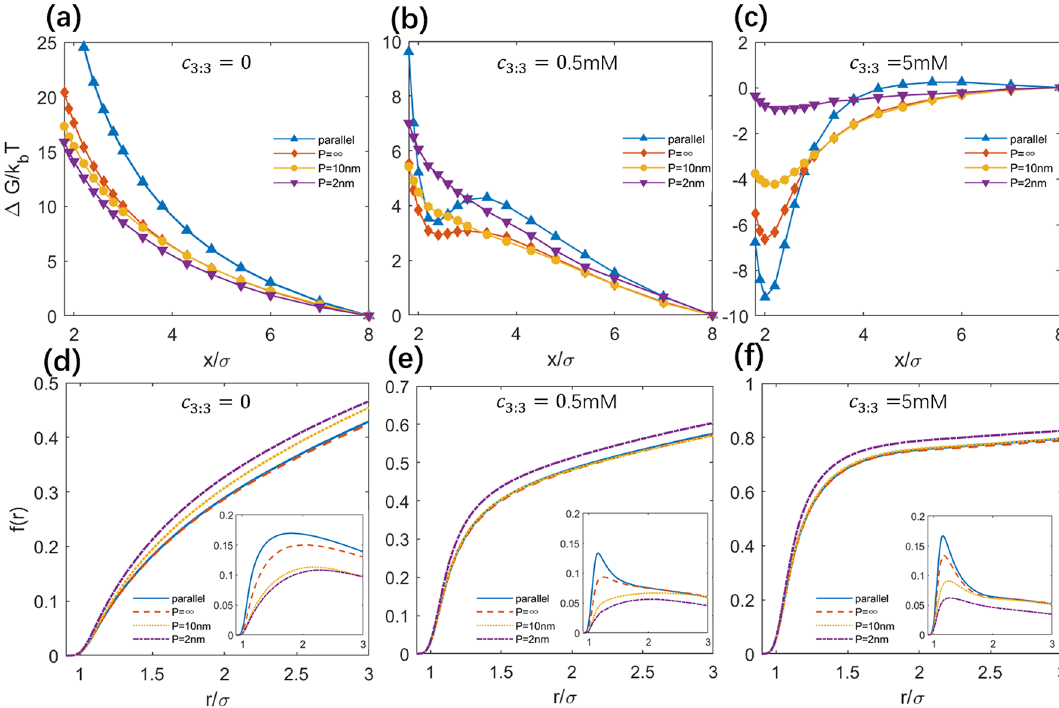
Figure 2. ( a – c ) Potentials of mean force between like-charged PEs with different intrinsic persistence lengths P for different salt conditions: 3:3 salt concentration c 3:3 = 0 ( a ), 0.5 mM ( b ) and 5 mM ( c ). ( d – f ) Charge fraction f ( r ) of ions around the PEs at x = 8σ for different salts: c 3:3 = 0 ( d ), 0.5 mM ( e ), and 5 mM ( f ). The insets are Δ f ( r ) = f ( r ) x =2σ - f ( r ) x =8σ at the corresponding salt conditions. It is noted that f ( r ) and Δ f ( r ) include all types of salt ions and counterions; see Eq. (8). Please note that the systems were always in the presence of 20 mM 1:1 salt buffer as described in “Model and simulations”